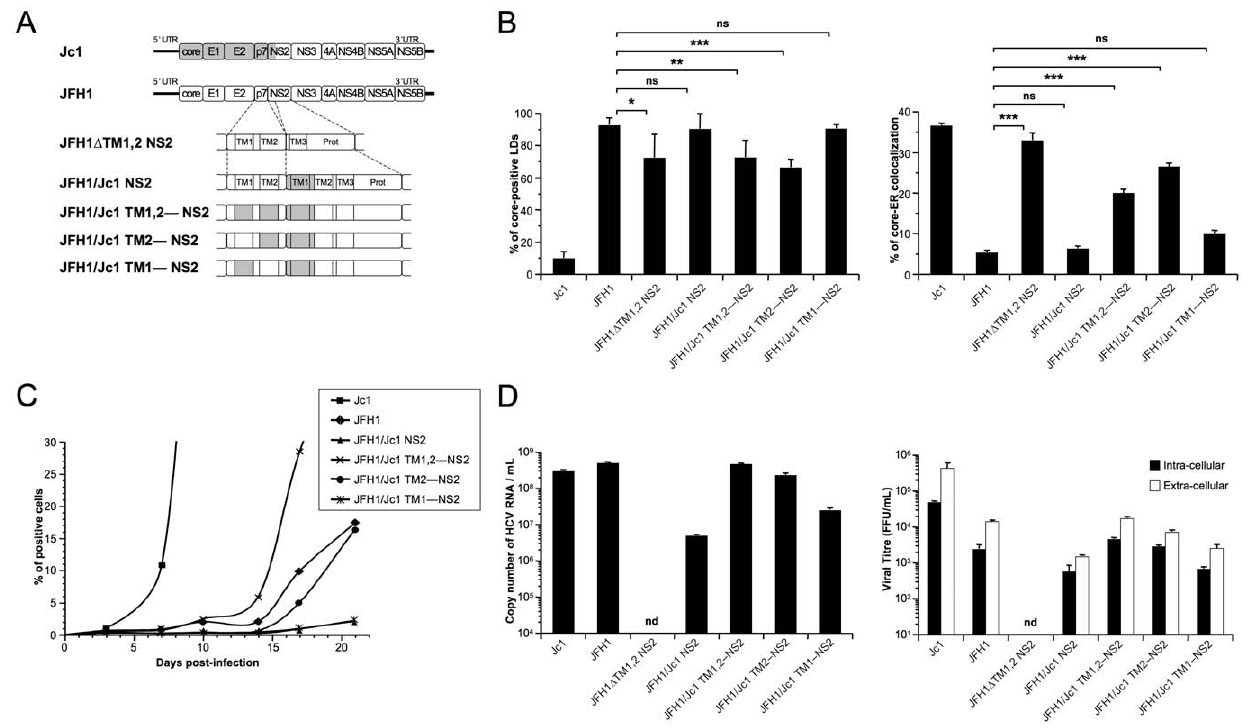
Figure 8. p7 and NS2 trans-membrane compatibility is sufficient to induce production of infectious HCVcc particle. Huh7.5 cells were transfected with full-length RNA derived from the JFH1 genome (white boxes) in which Jc1 sequences (gray boxes), encompassing the trans- membrane segments (TM1 and/or TM2) of p7 and/or NS2, were substituted, or deleted, as indicated ( A ). Prot, NS2 protease domain. Cells were stained 72 h post-transfection for LDs, Calnexin, and HCV core proteins. Intracellular localization of core proteins in LD or ER was analyzed by confocal microscopy. The frequency of JFH1 or Jc1 core-positive LDs (mean % 6 SD) was determined in HCVcc-containing cells stained for core and LDs (left panel). The percentages of core-ER colocalization (mean % 6 SD) were determined by expressing the coefficients of determination based on Pearson’s correlation coefficients of colocalization of core and Calnexin (right panel). For each condition, 30–50 cells were quantified. (*), P , 0.05; (**), P , 0.01; (***), P , 0.001; (ns), no significant difference ( B ). The viral spread in cells infected at MOIs of 0.01 by Jc1, JFH1 and chimeric JFH1 HCVcc was determined for 21 days post-infection, by NS5A immuno-staining ( C ). The copy numbers of HCV RNA (per ml) were determined in the supernatants of HCVcc-expressing cells by RT-qPCR 3 days post-transfection. Jc1 HCVcc input was diluted to 1/100 (left panel). The infectious titers of intra-cellular particles, present in lysates of HCVcc-containing cells, and of extra-cellular particles, present in the supernatants of HCVcc-containing cells, were determined (right panel) as NS5A-FFU/ml (mean 6 SD, n=4). nd, not detectable ( D